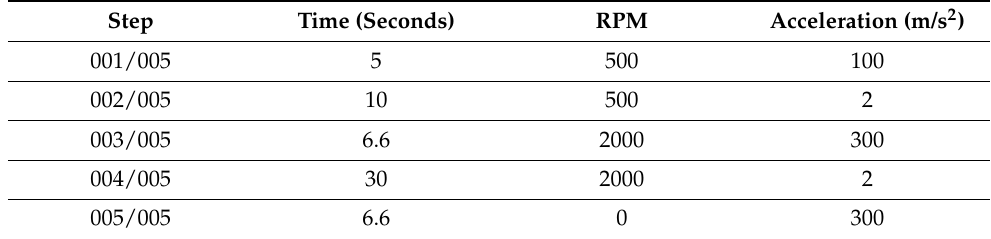
Table 3. Time, RPM, and acceleration conditions for each cycle of the spin coater for 150 µ m thickness. An acceleration of 2 m/s 2 is used to indicate no acceleration in the spin coater.